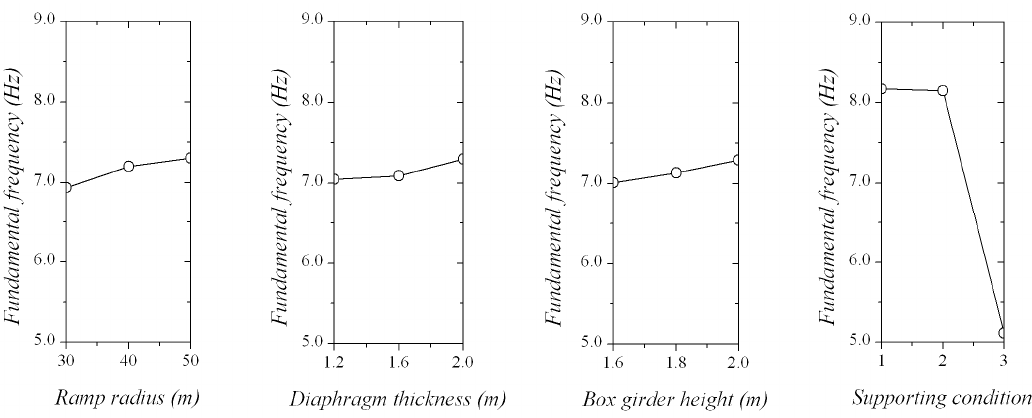
Figure 9. Influence of varying parameters on the torsion vibration fundamental frequency.